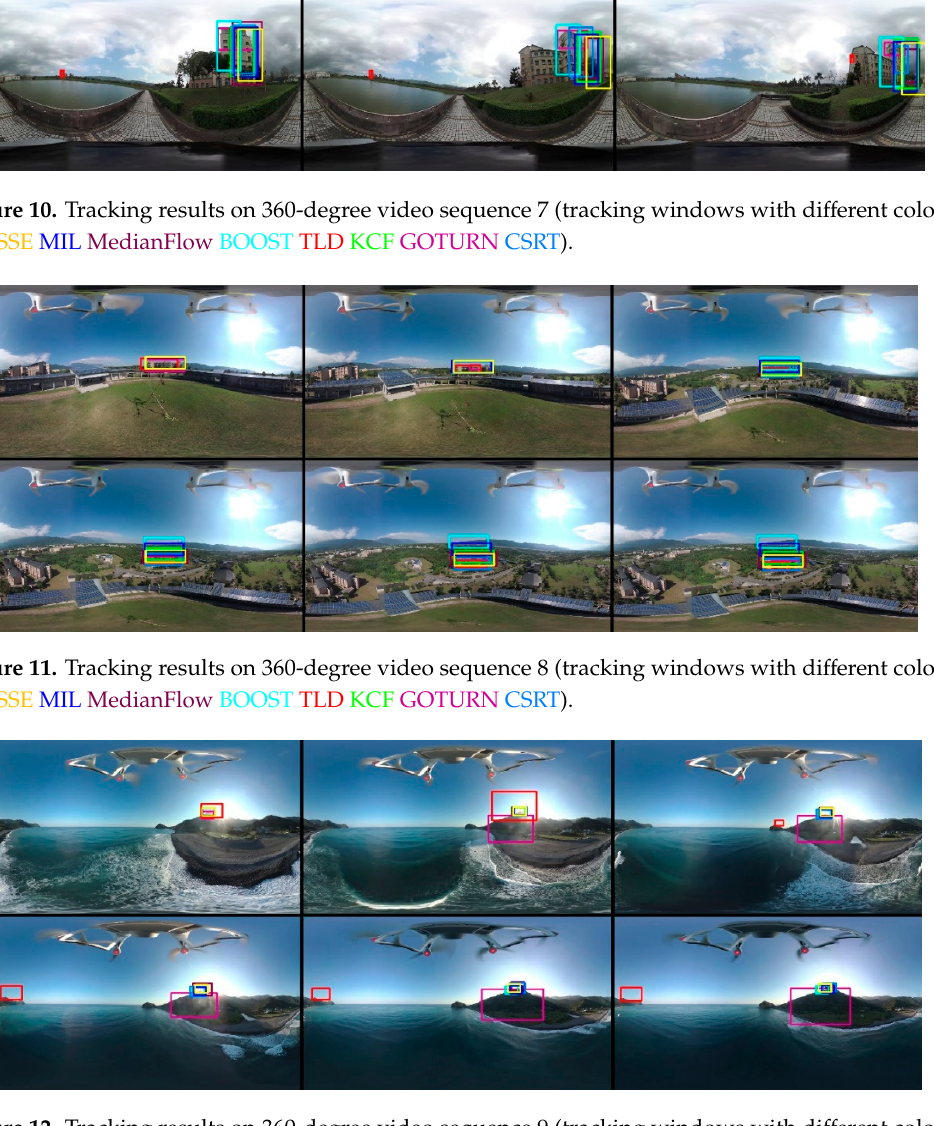
Figure 12. Tracking results on 360-degree video sequence 9 (tracking windows with different colors : MOSSE MIL MedianFlow BOOST TLD KCF GOTURN CSRT).